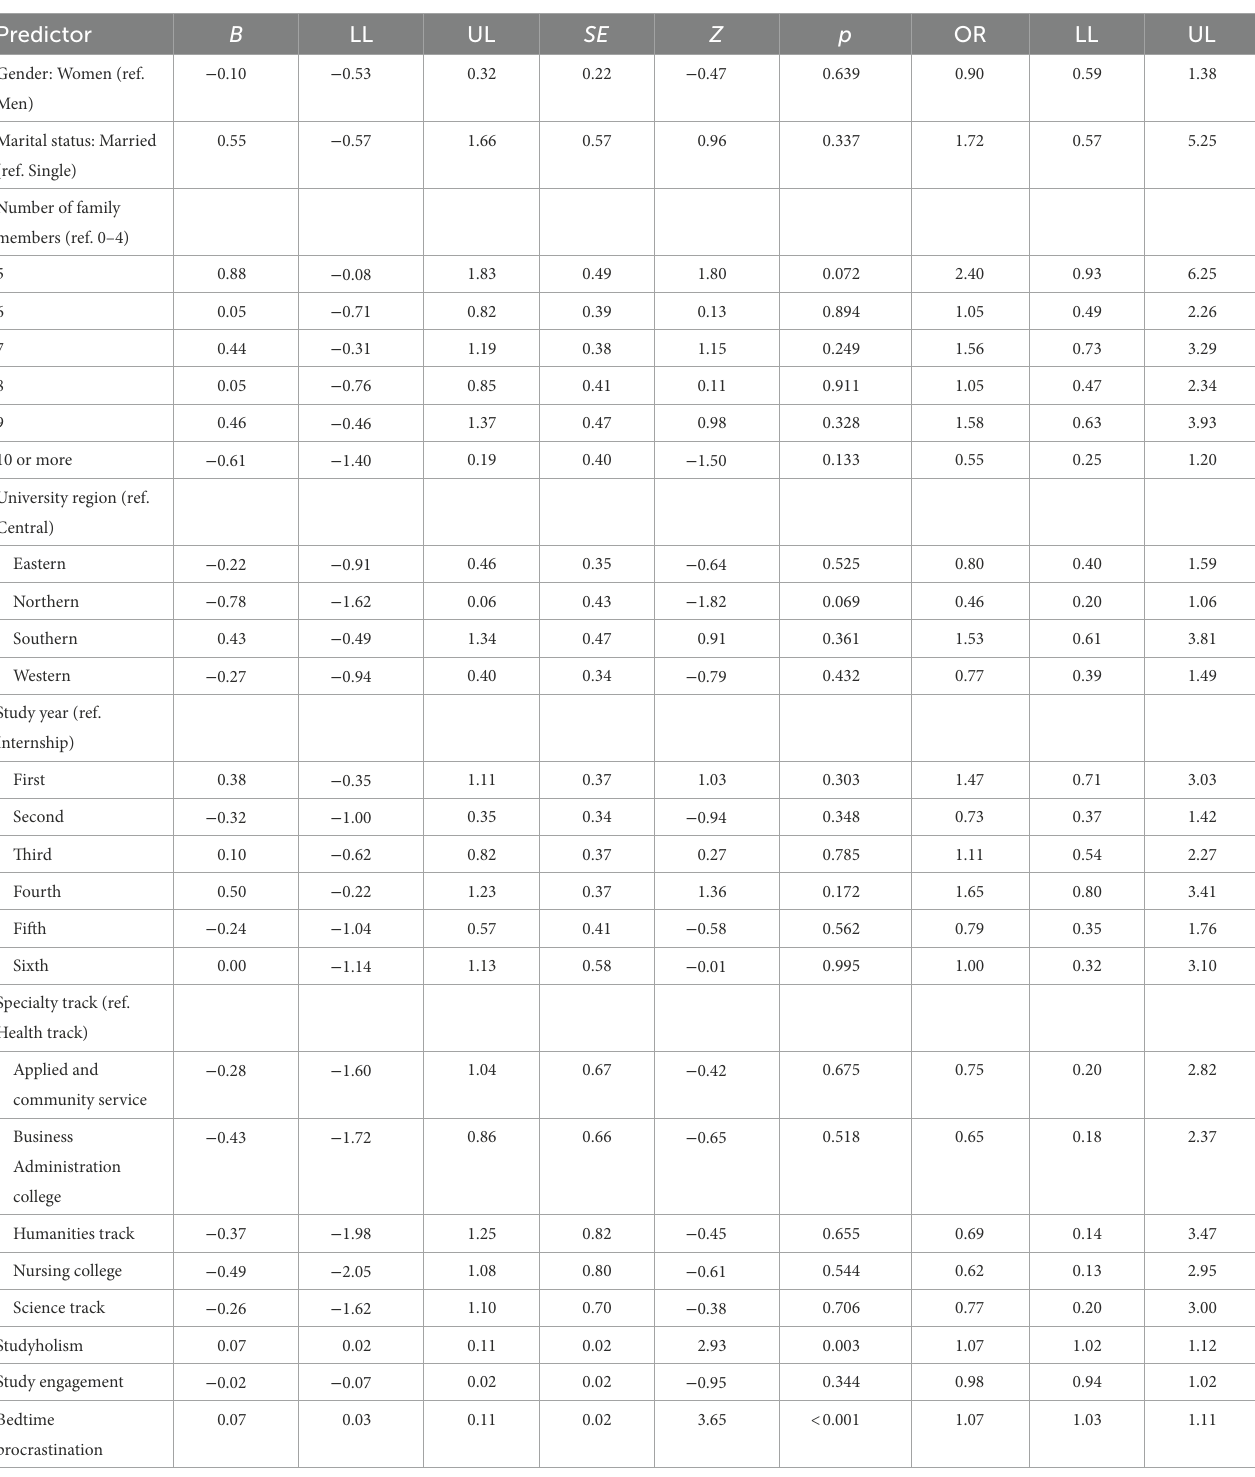
TABLE 6 Binomial logistic regression for insomnia (crude odds ratios).